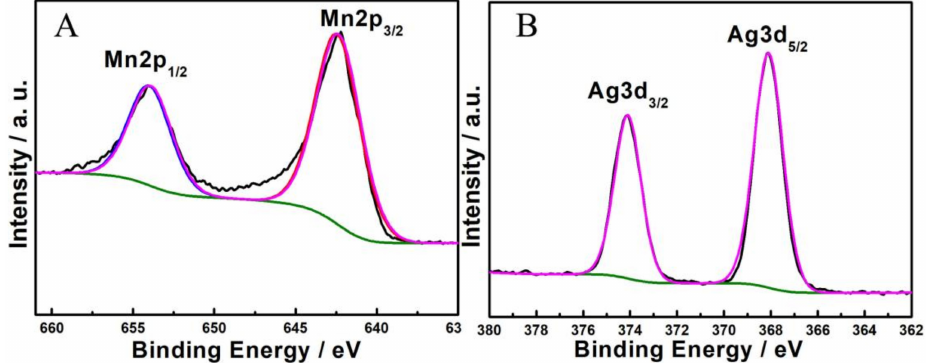
Figure 3. XPS of Mn-Ag-0.10: ( A ) Mn 2p ( B ) Ag